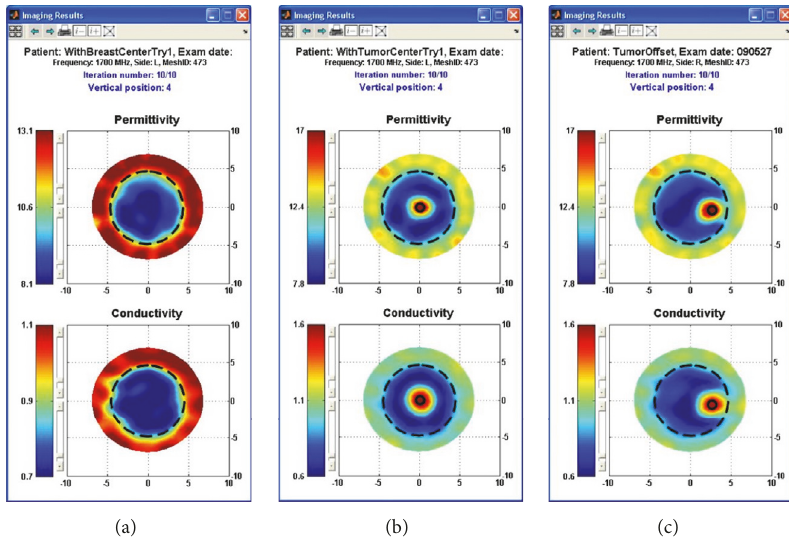
Figure 14: Reconstructed images of cylindrical tumor (10mm diameter pipe) inside bath liquid at ETRI. (a) Breast without tumor (b) with tumor at center and (c) with tumor 30 mm right of center [21]. Image copyright ETRI, used with permission.